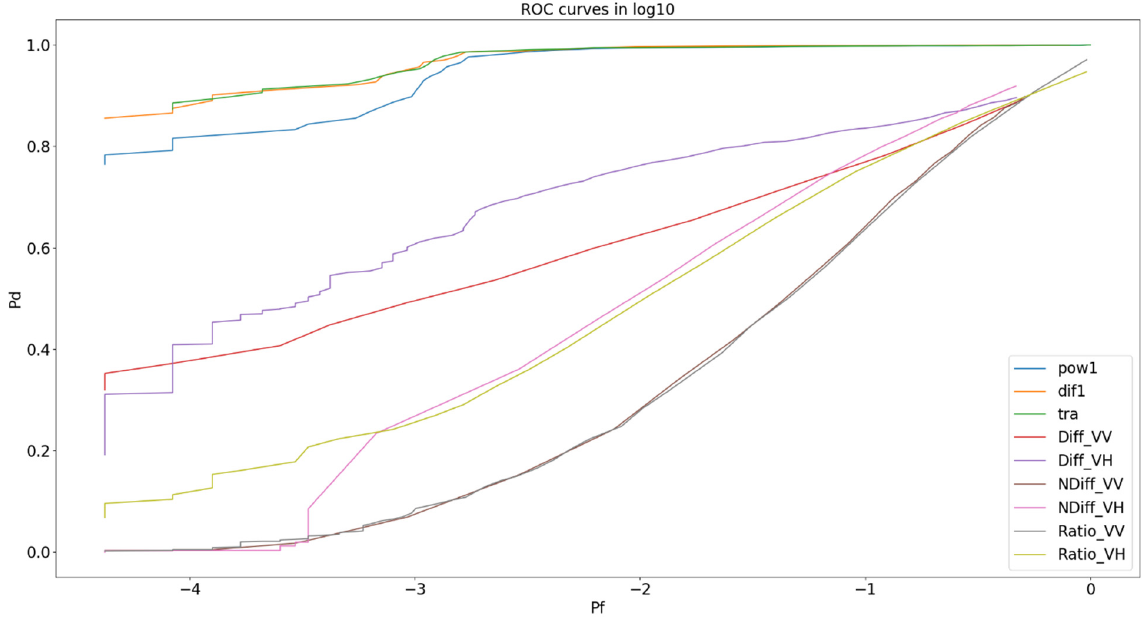
Figure 11. ROC Curve in Log10 showing change detectors used on 19 January 2020 barrage & 24 April 2020 data: Difference VV and VH (Diff_), Ratio VV and VH (Ratio_), Normalised Difference (NDiff_), Power Difference (Dif1), Power Ratio (Pow1) and Trace (HLT).